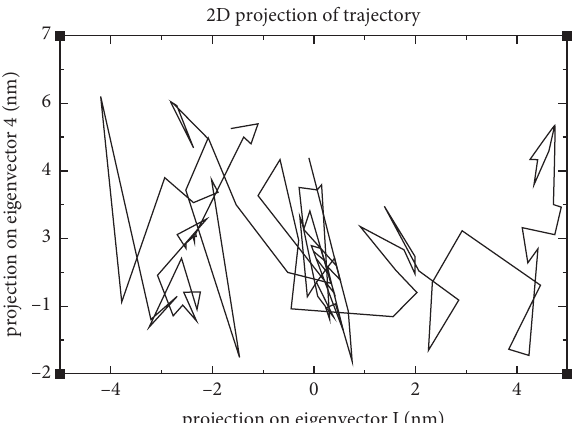
Figure 12: Scree plot for PCA on the MD coordinate data of the protein-ligand complex. *e plot shows the variation extent each PC captures from the data. *e eigenvalues (nm2) stand for the variation amount while the eigenvector index represents the PCs.